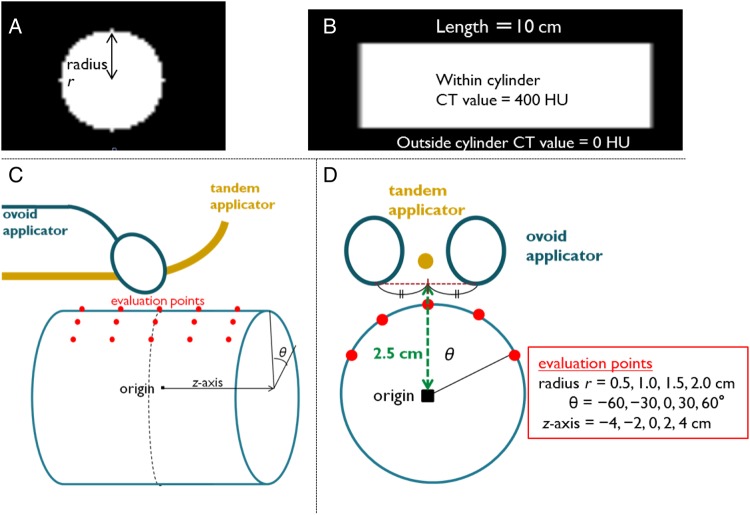
Virtual phantom. Four cylindrical virtual phantoms mimicking the rectum were generated on the CT image set. (A) Axial and (B) sagittal planes. The radii of the phantoms were 0.5, 1.0, 1.5 and 2.0 cm and the lengths were all 10 cm. (C) Schematic diagram of the virtual phantom study and (D) a cranial view. The typical dose distributions of ICBT were projected onto the virtual phantom CT images. When the typical dose distribution was generated, virtual tandem and ovoid applicators were set. There were 25 points for dose evaluation located on the surface of the phantom. Abbreviations: CT = computed tomography.